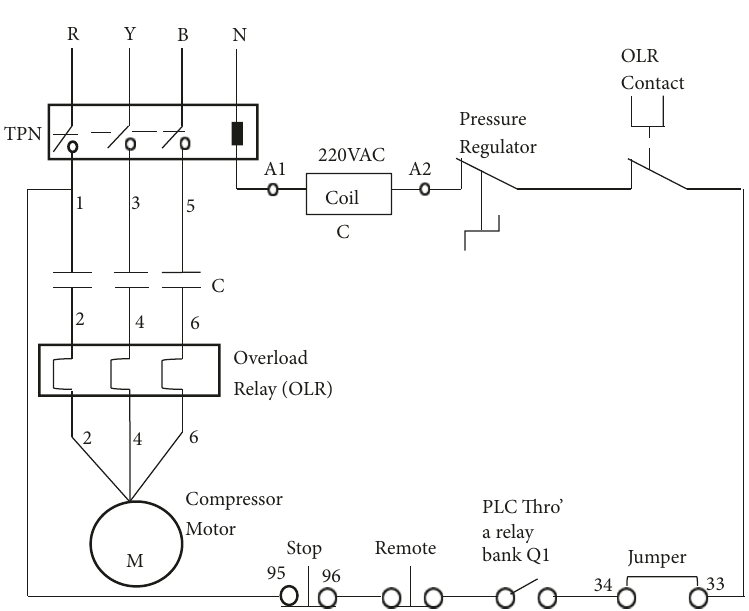
Figure 9: Schematic diagram for a remote control of air-compressor system by PLC.